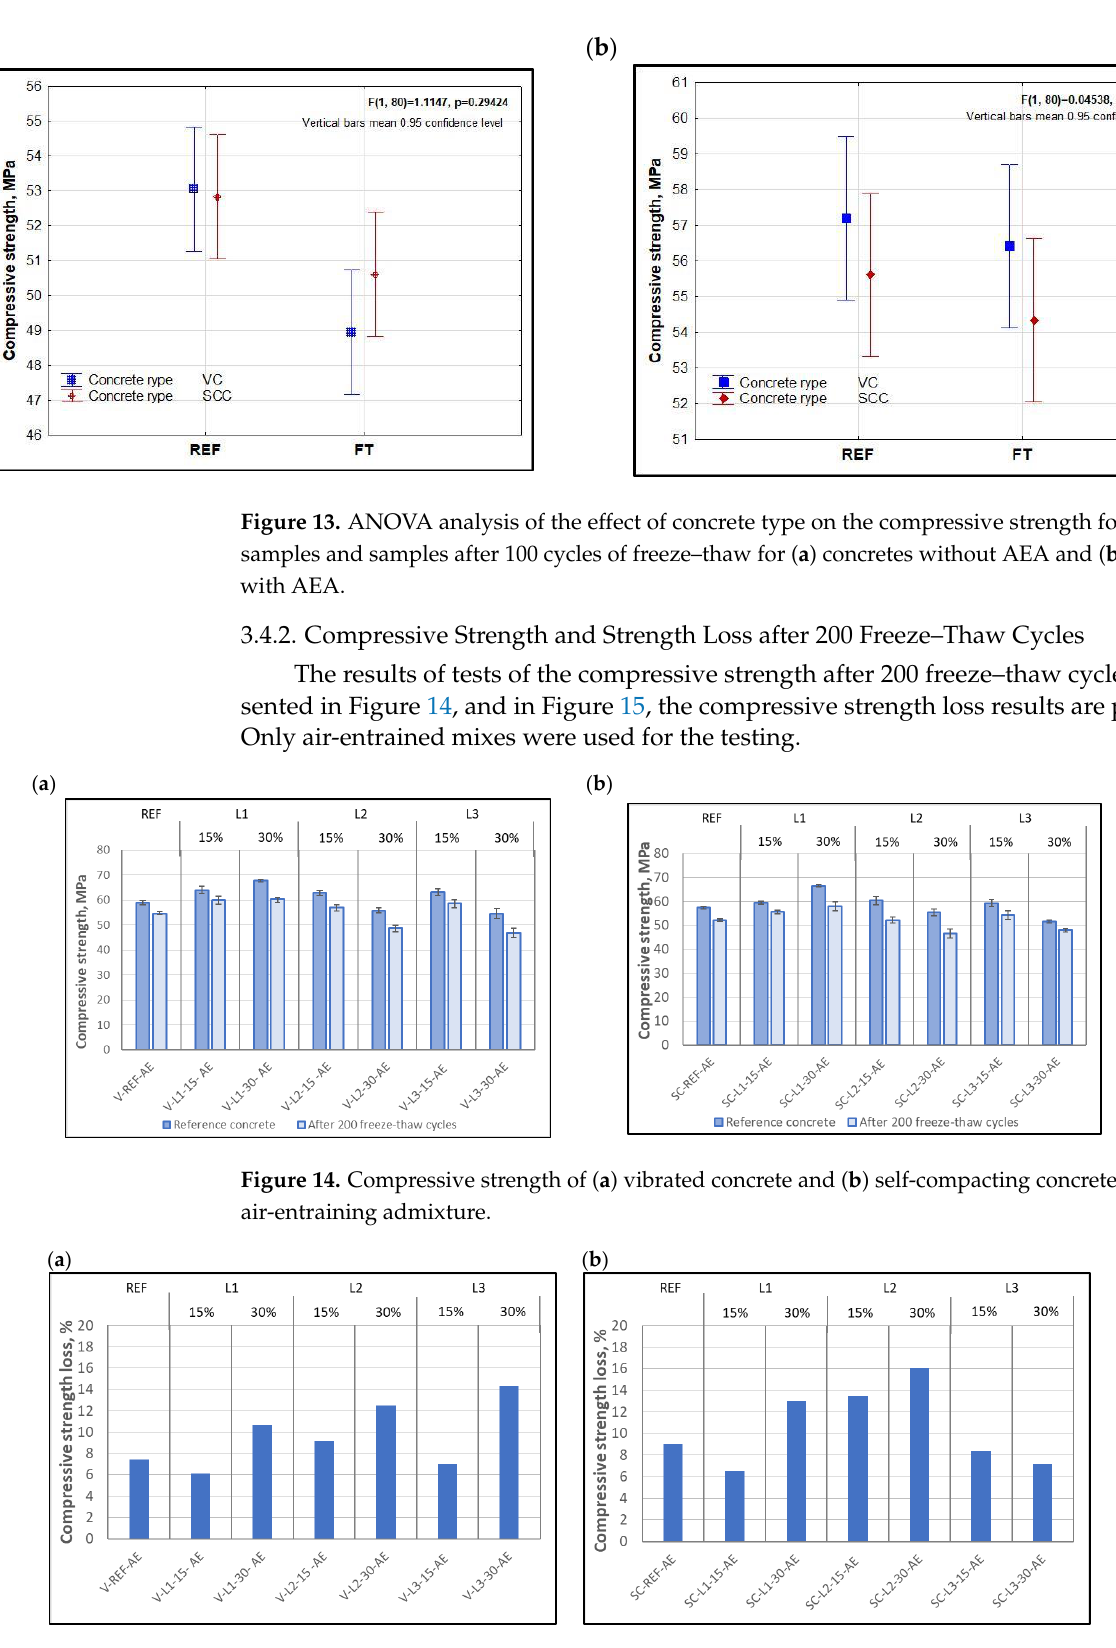
Figure 15. Strength loss for ( a ) vibrated concrete and ( b ) self-compacting concrete, both with air- entraining